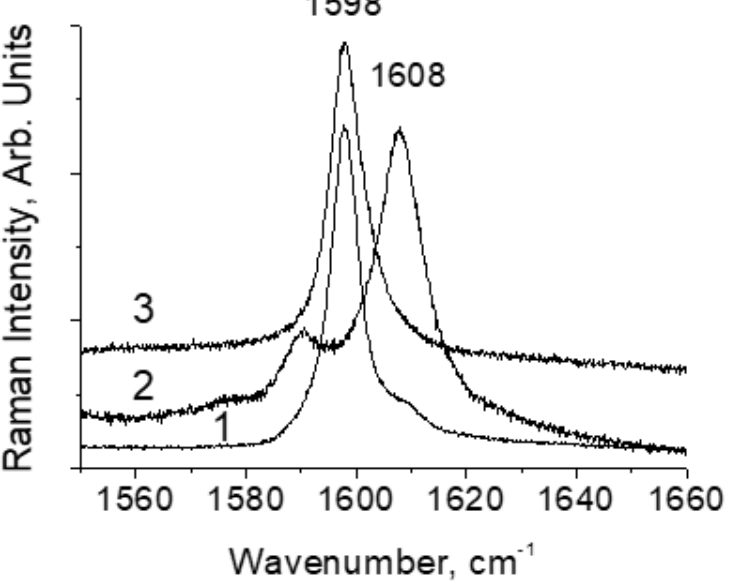
Figure 4. Room temperature Raman spectra of DBM ( 1 ), DBM-OMe ( 2 ), and DBM-NO 2 ( 3 ) com- pounds in the range of vibrational frequencies of the C=O bonds of the e-cycle.